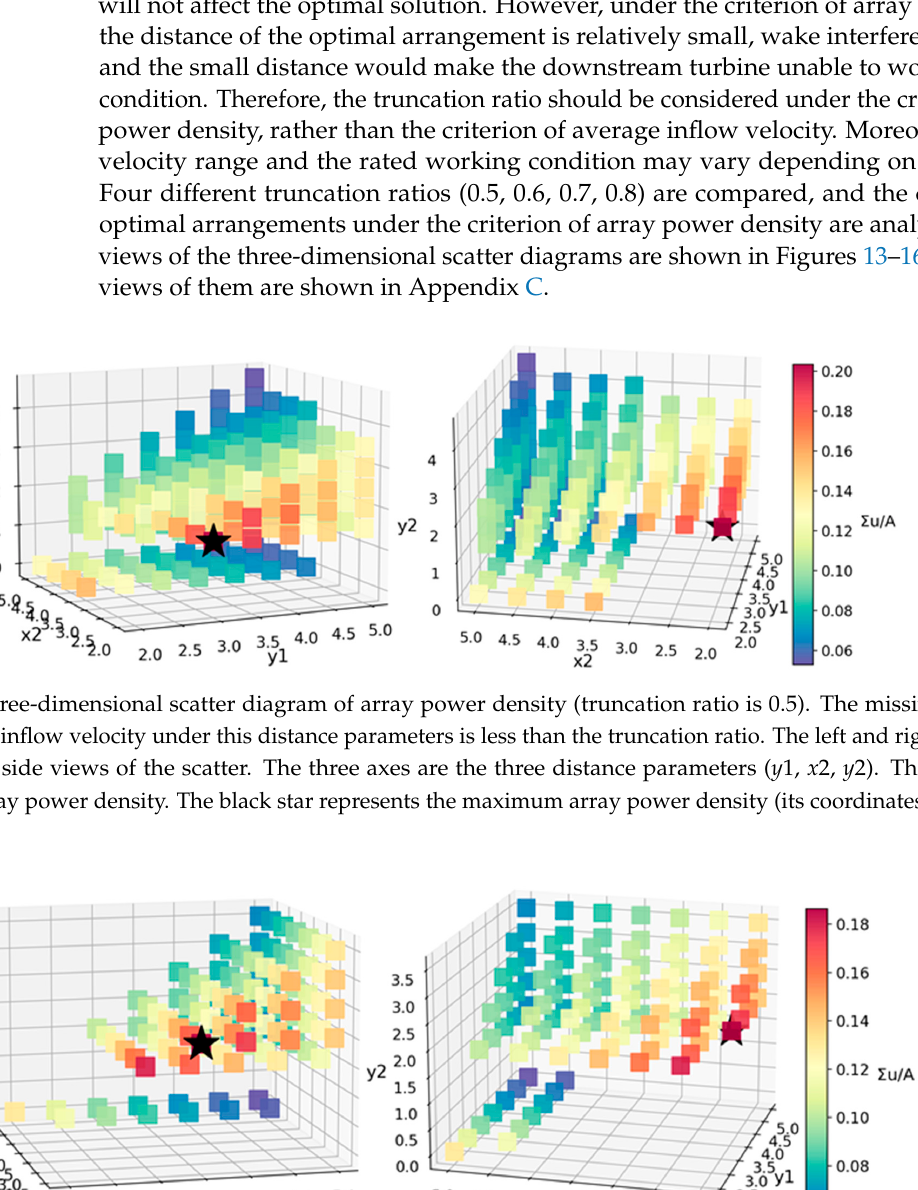
Figure 15. The three-dimensional scatter diagram of array power density (truncation ratio is 0.7). The missing scatters represent that the inflow velocity under this distance parameters is less than the truncation ratio. The left and right pictures are two different side views of the scatter. The three axes are the three distance parameters ( y 1, x 2, y 2). The color bar represents the array power density. The black star represents the maximum array power density (Its coordinates are y 1 = 4, x 2 = 2.5, y 2 = 2).